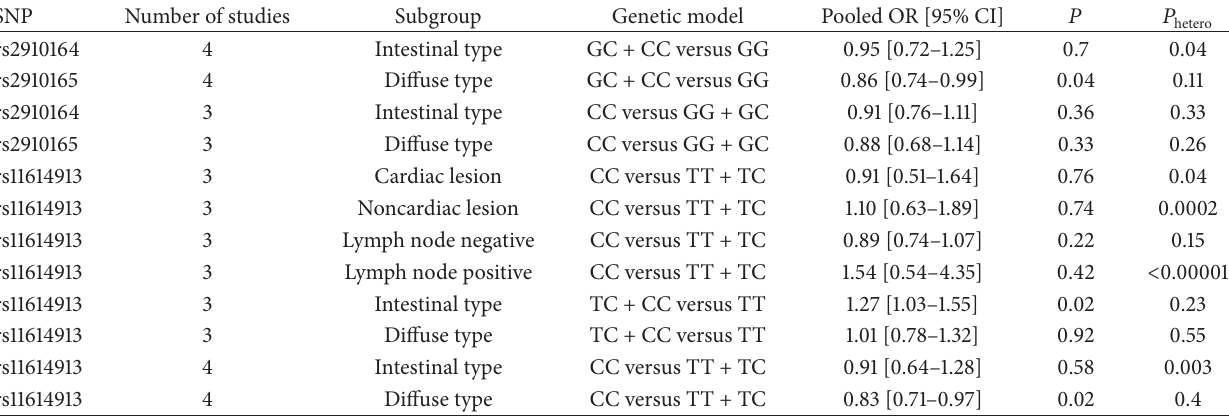
Table 5: Summary of pooled ORs in subgroup analyses.